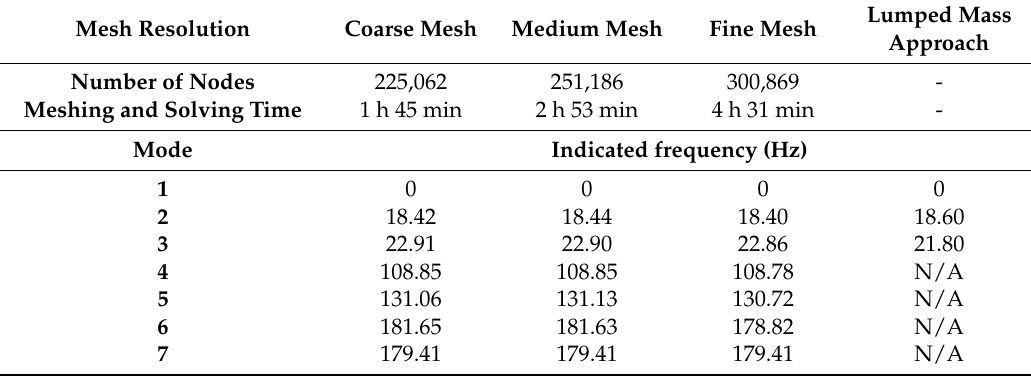
Table 2. Mesh size, number of nodes, and meshing and solving time 1